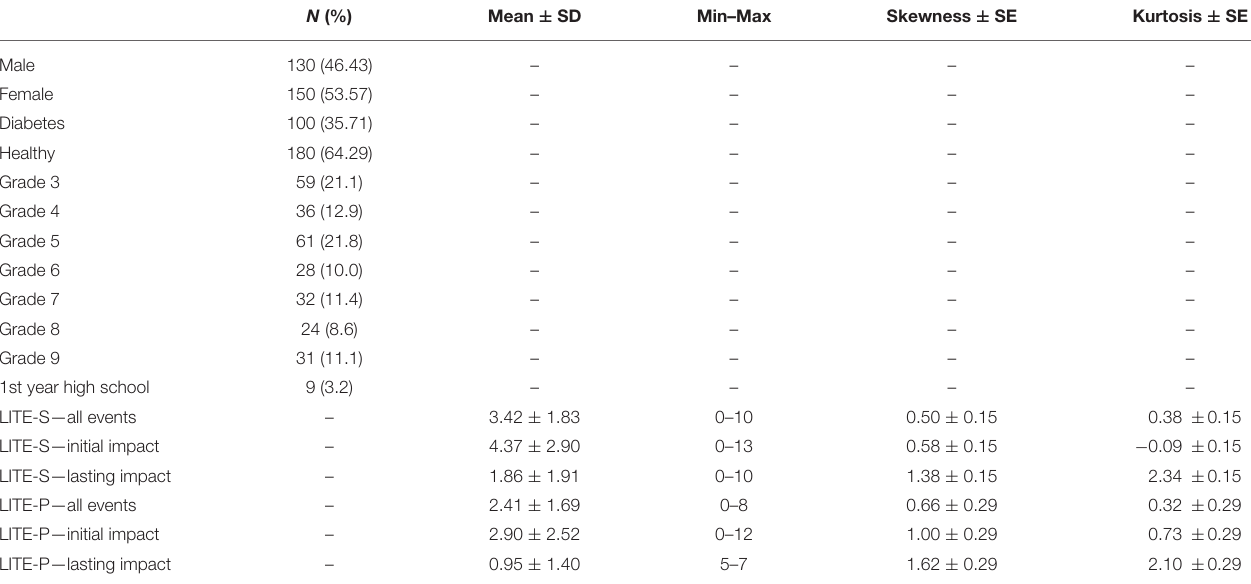
TABLE 1 | Descriptive statistics for the sample and traumatic events scales reported by the children and the parents ( N = 280).